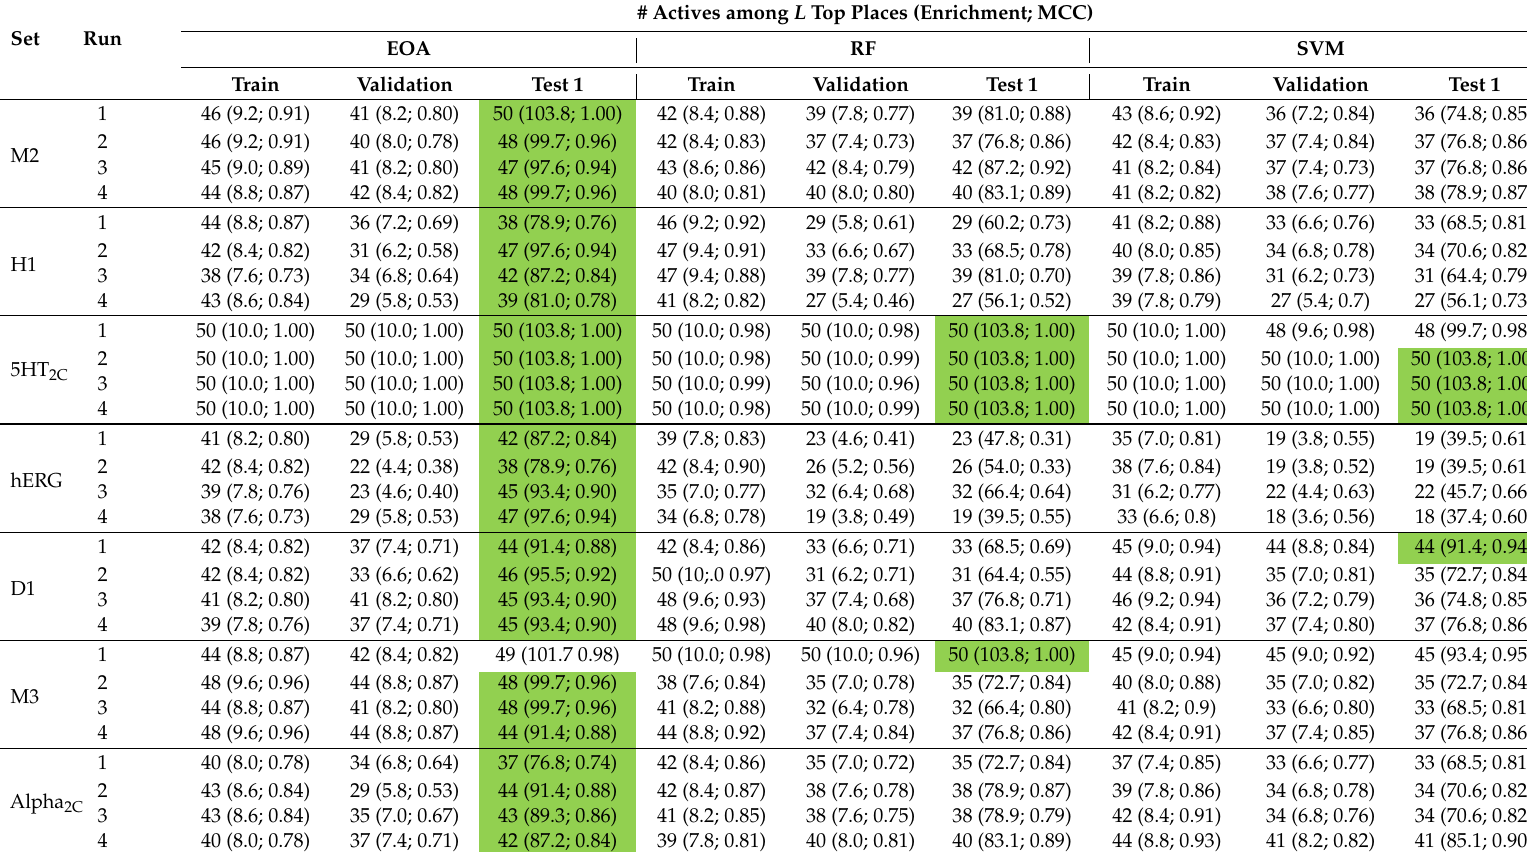
Table 3. A comparison of the performances of Enrichment Optimizer Algorithm (EOA) models with those of Random Forest (RF) and Support Vector Machine (SVM) for the seven datasets considered in this work. For EOA we provide the results obtained with the best models as determined according to performances on test set 1. A complete listing of the results obtained with all models is provided in Tables S2–S8 (2nd–5th sheets) of the Supplementary Materials. Each cell contains the number of active compounds found within the first L places and in parenthesis, the enrichment calculated according to Equation (5) and the Matthews Correlation Coe ffi cient (MCC). Green coloring represent the best models (as judged be performances on the test set) from within EOA, RF and SVM.